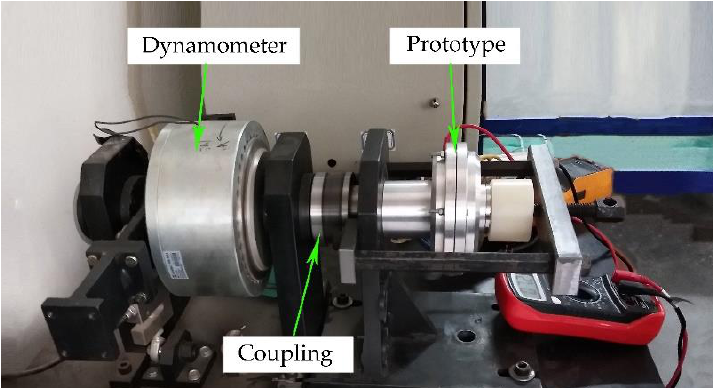
Figure 16. Experimental test platform.